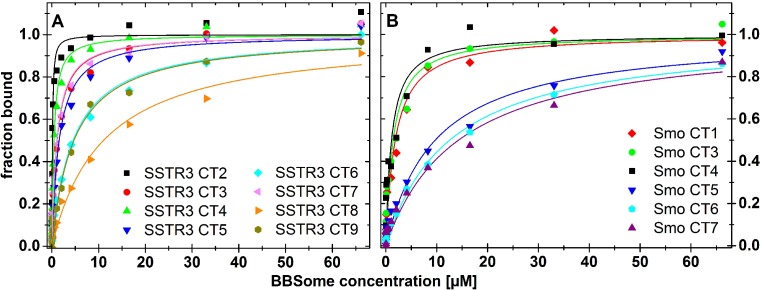
Mutational analysis of the BBSome binding peptides.Fluorescence polarization experiments with fluorescent peptides at concentrations of 0.1 µM. The peptides SSTR3 CT2 (A) and of Smo CT4 (B) that bound with highest affinity to the core BBSome were used as templates for the design of mutant peptides with one or multiple aromatic/basic residue motifs changed to alanines as summarized in Table 1. Core BBSome was added at the indicated concentrations and the increase in fluorescence polarization was monitored as a measure for the peptides binding to the protein complex. The binding curves were fit as described in the methods section, and the resulting maximal polarization from the fit was defined as 100% of the peptide bound to the complex (fraction bound = 1).